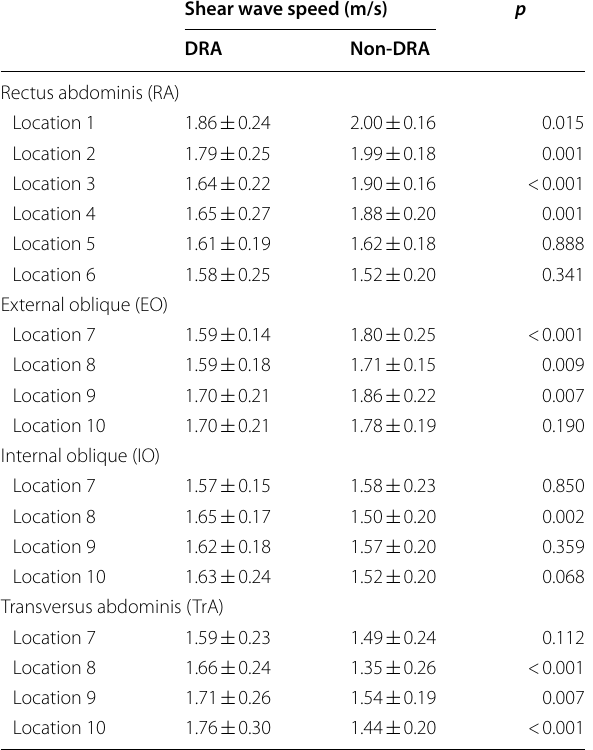
Table 4 Correlation coefficients among the US variables in the 36 DRA patients Findings